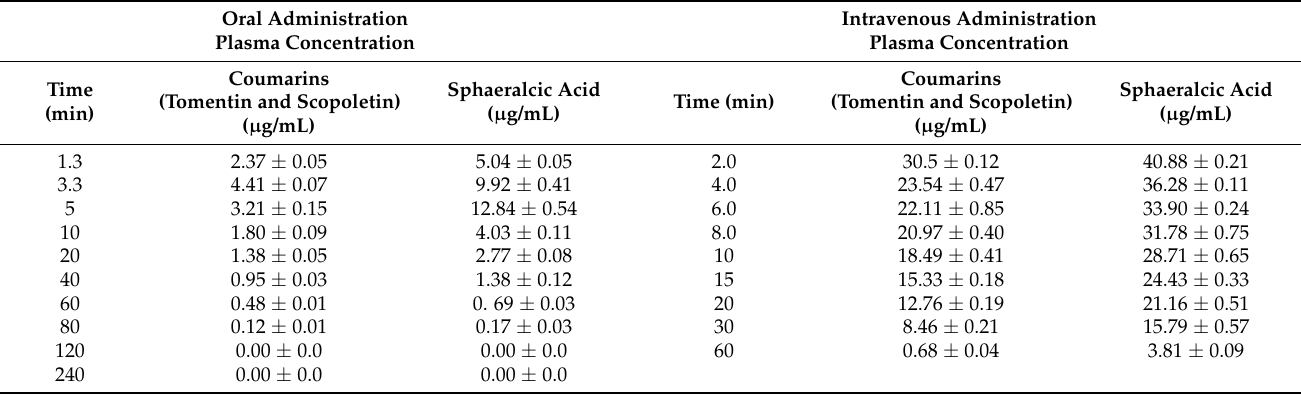
Table 3. Variation of coumarins (tomentin and scopoletin) and sphaeralcic acid concentrations in plasma during the initial 4 h after oral administration and in the first hour after intravenous administration, of a single dose (400 mg/kg) of the SaTES standardized fraction in ICR mice.